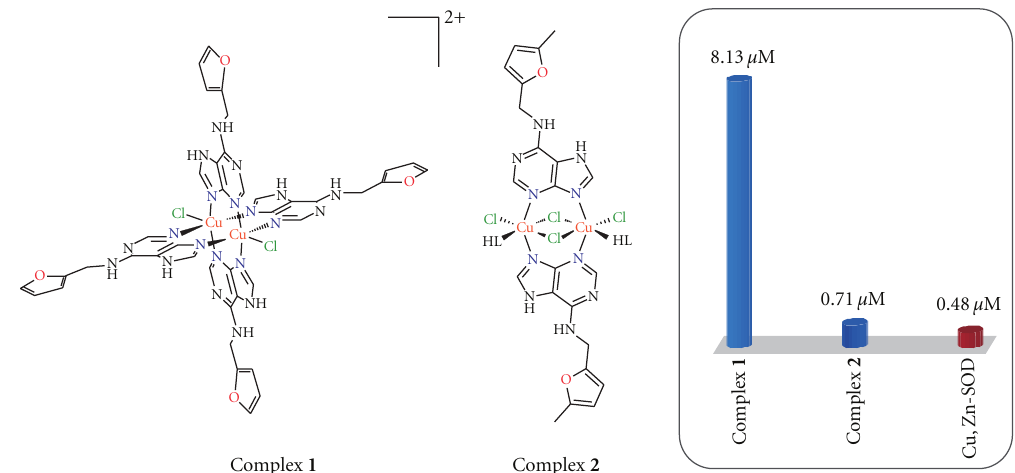
Figure 6: Proposed structures of the presented complexes 1 and 2 with their in vitro SOD-mimic activity (expressed as the IC 50